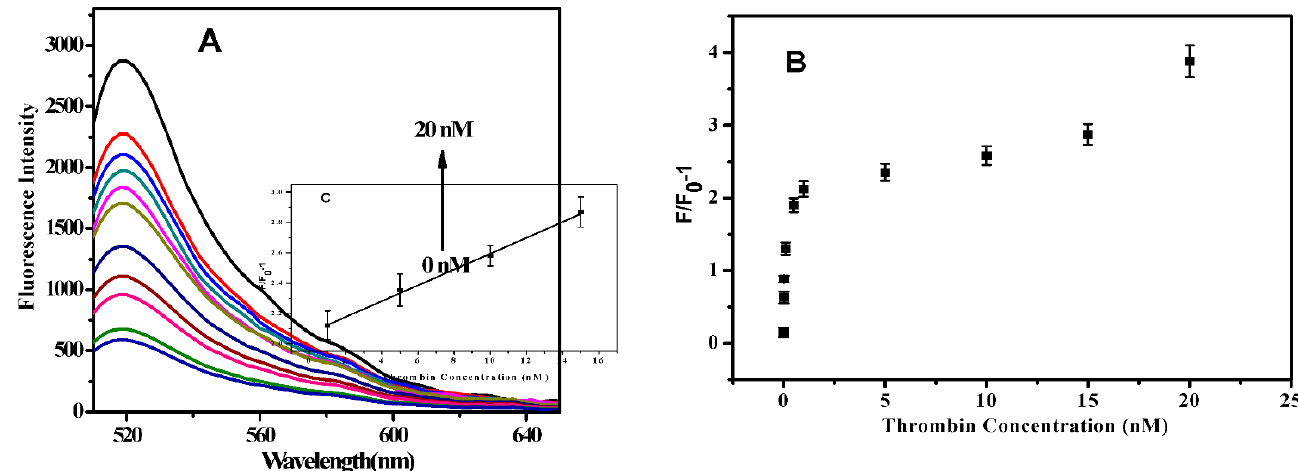
Figure 2. ( A ) The fluorescence intensity of the GO-DNA sensor by covalent linking in the presence of different concentrations of thrombin (0.00025, 0.005, 0.01, 0.1, 0.5,1, 5, 10, 15, and 20 nM); ( B ) the values of F/F 0 -1 for the assay with the concentrations of thrombin; ( C ) the values of F/F 0 -1 for detection with the concentrations of thrombin. The number of samples was 5.